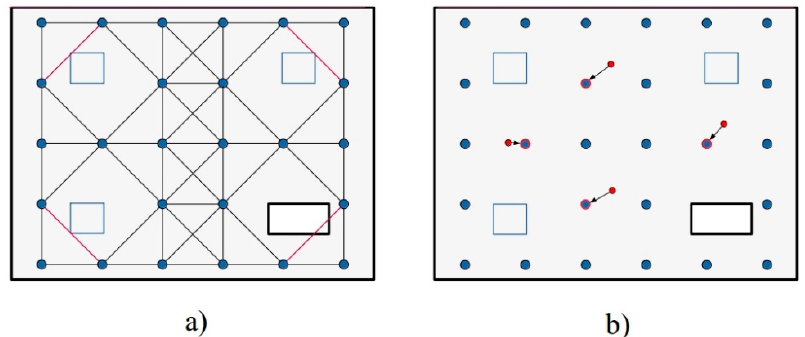
Figure 10. ( a ) Graph nodes are 8-connected by edges and the ones intersecting with any no-navigable space are removed (magenta). ( b ) Scanning positions (red points) are relocated to nearest nodes to them (blue points with red contour).